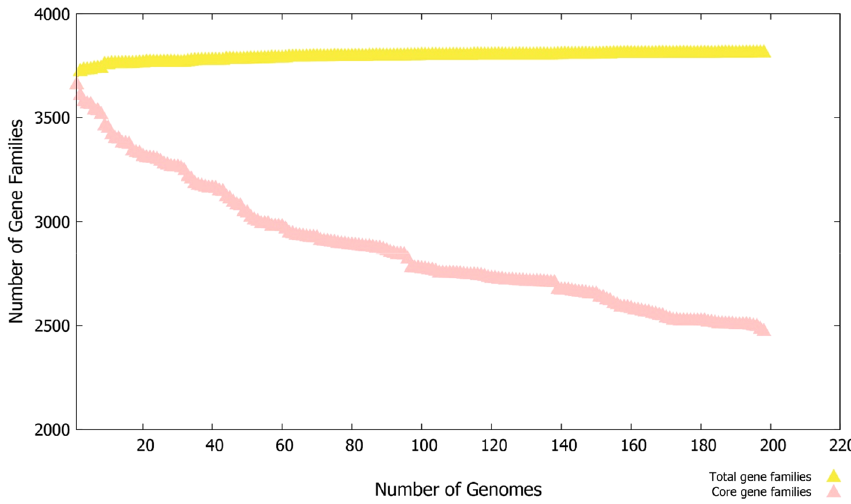
Figure 2. Pan-genome anlaysis plot of 200 M. tuberculosis genomes